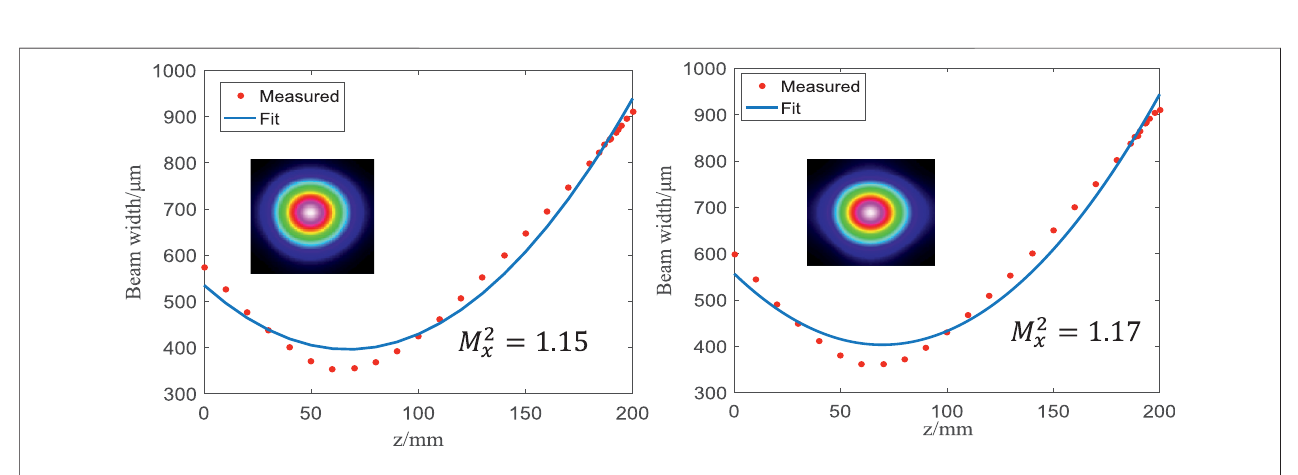
FIGURE 15 | The beam characteristics of the single laser